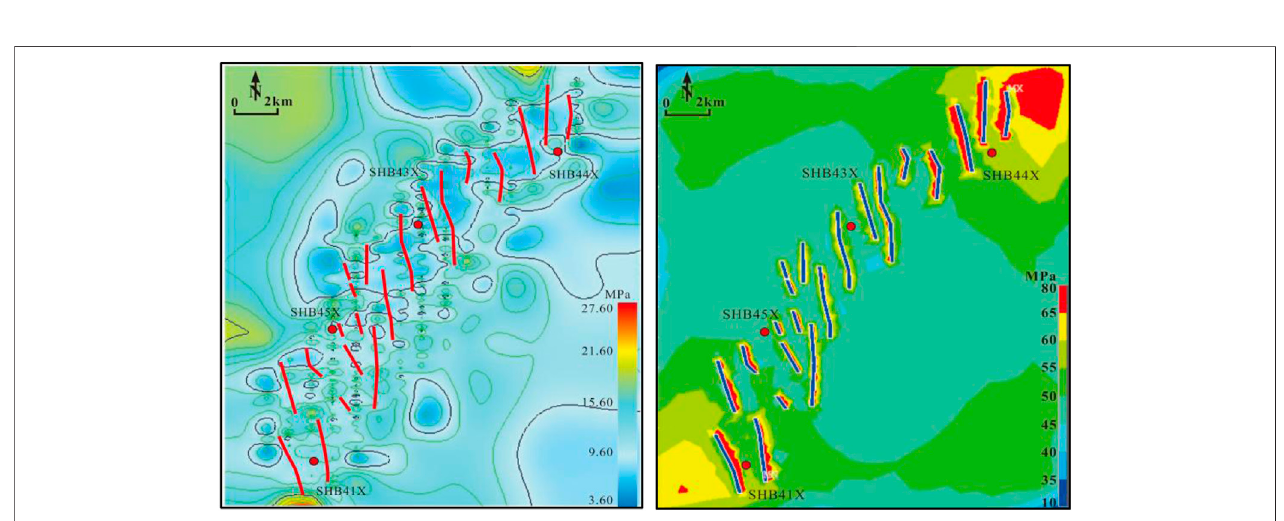
FIGURE 14 | Planar distribution of shear stress and horizontal stress difference at T 63 interface of Shunbei No. A Fault Zone.